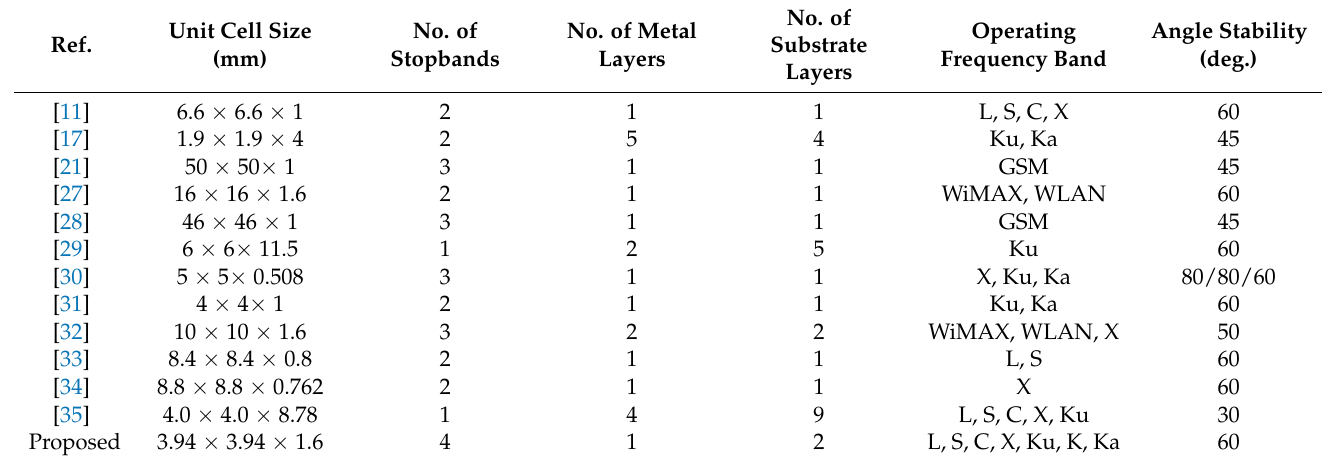
Table 4. Comparative analysis of the proposed FSS and other reported